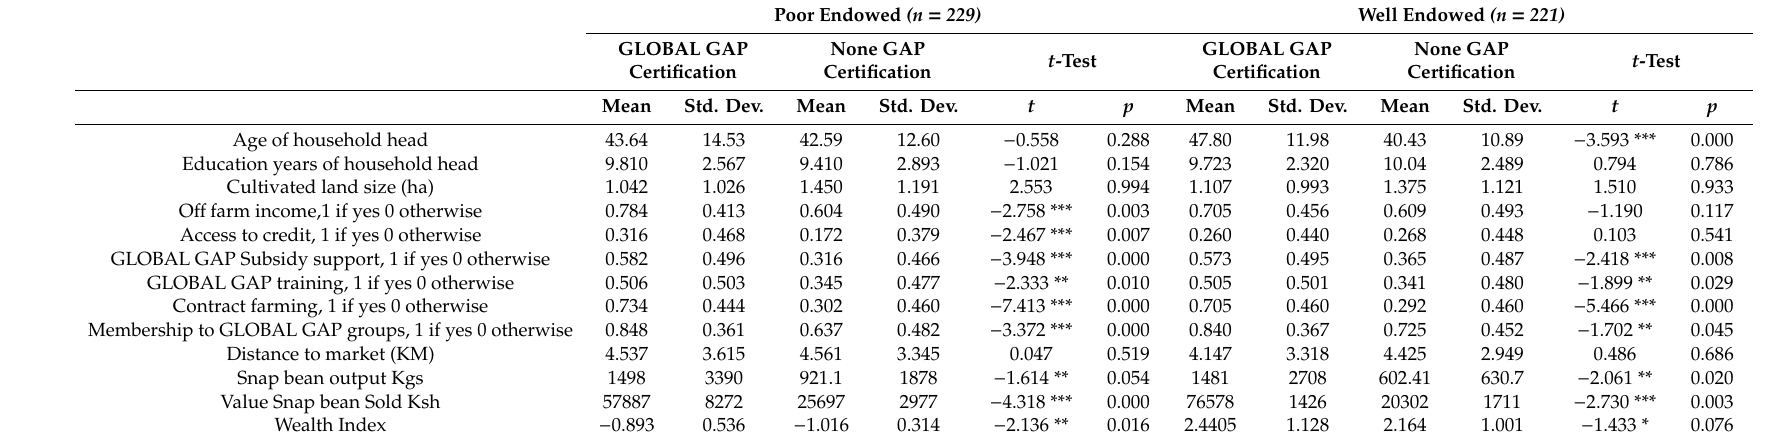
Table 3. Descriptive Statistics of Variables Included in the